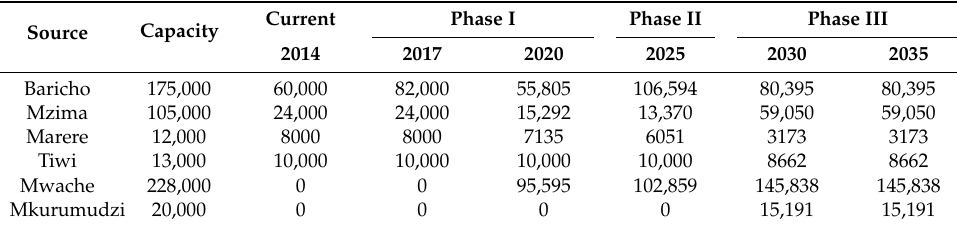
Table 6. Planned future flows to Mombasa City in m 3 /day [34].